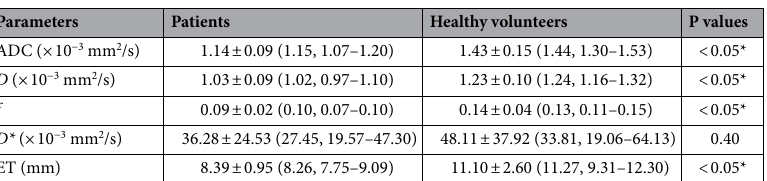
Figure 1. A flow chart of the enrolled patients.